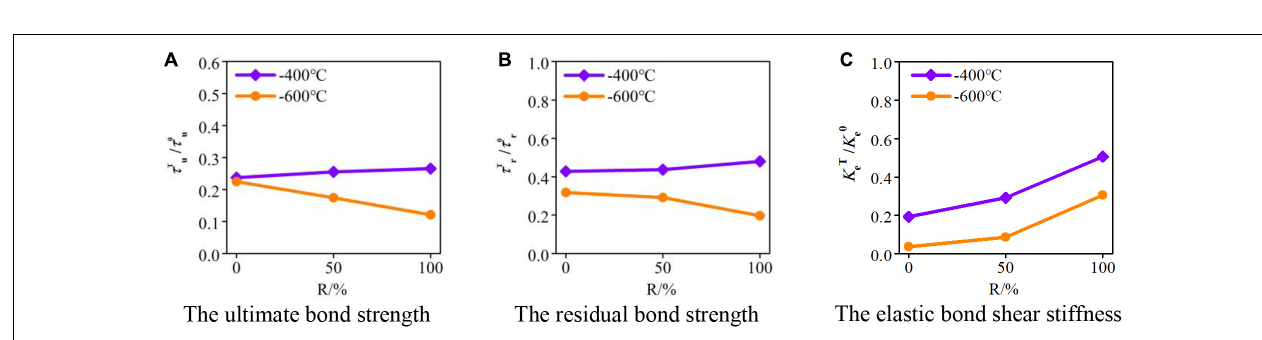
FIGURE 7 | Effect of cooling regime. (A) The ultimate bond strength. (B) The residual bond strength. (C) The elastic bond shear stiffness.